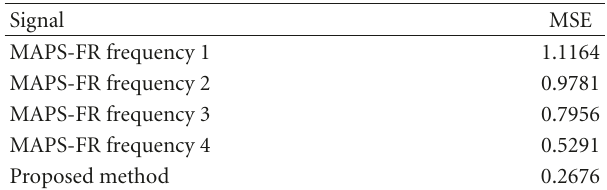
Table 5: Comparison between pure MAPS-FR signals and pro- posed method’s signal and load